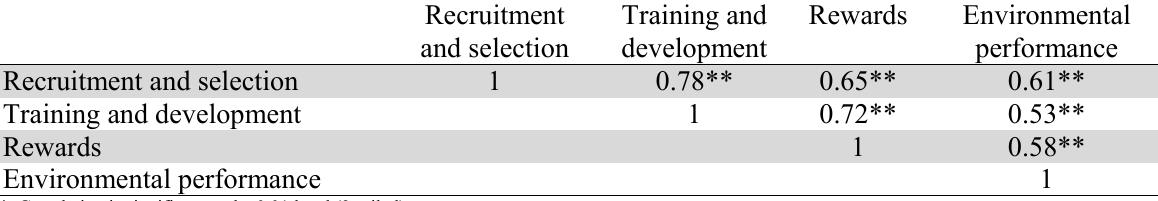
The correlation between survey items